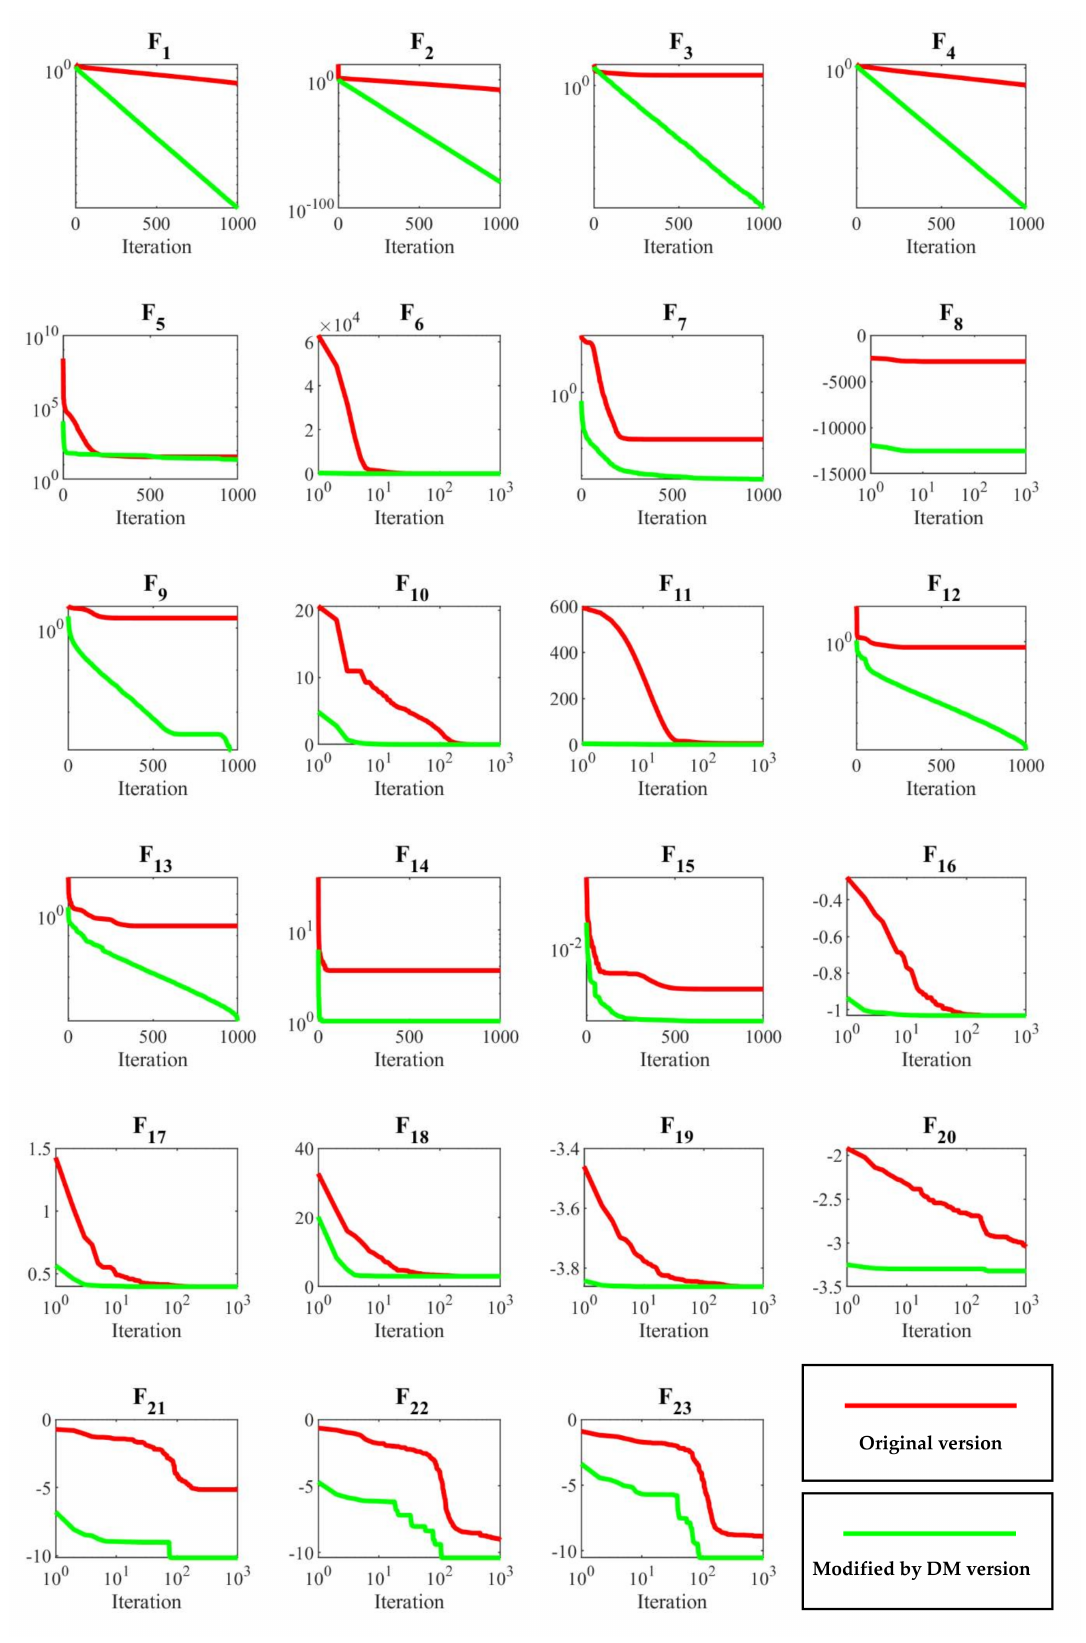
Figure 5. The convergence curves of GSA for original and “modified by DM”